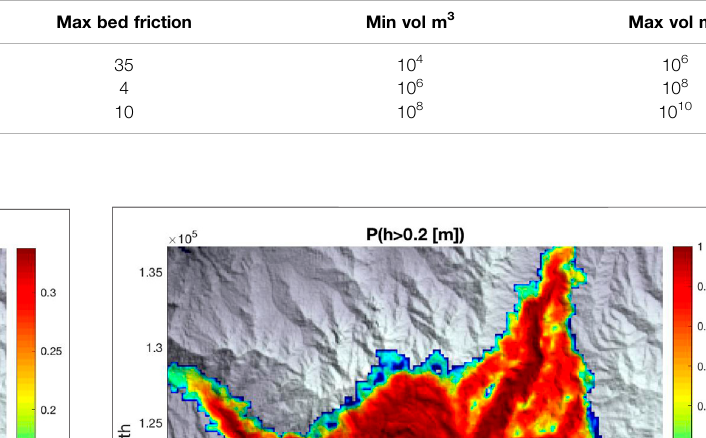
TABLE 4 | Eruption PHM Scenarios for Azufral volcano, Colombia.